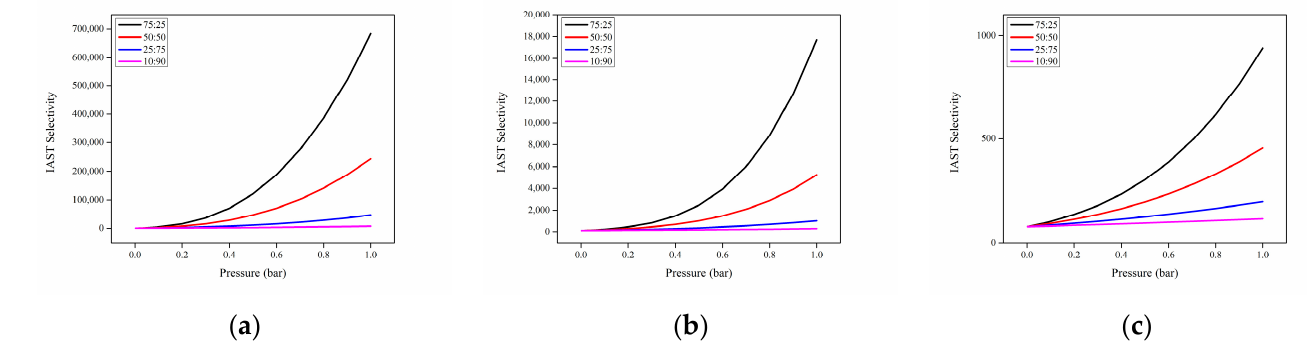
Figure 12. IAST selectivity of CO 2 and CH 4 at: ( a ) 273 K; ( b ) 298 K and ( c ) 313 K, respectively.